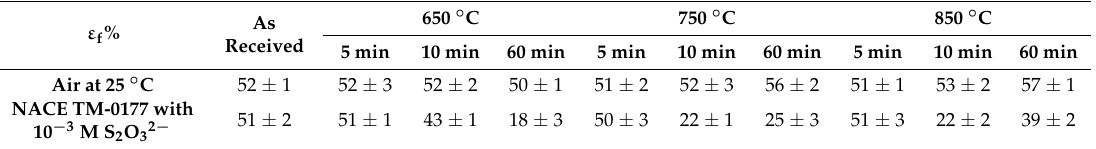
Table 4. Average values and standard deviations of ε f % from slow strain rate tests (SSRT) performed in air at 25 °C and in NACE TM-0177 in the presence of 10 − 3 M S 2 O 32 − on DSS 2304 as-received and thermally aged.